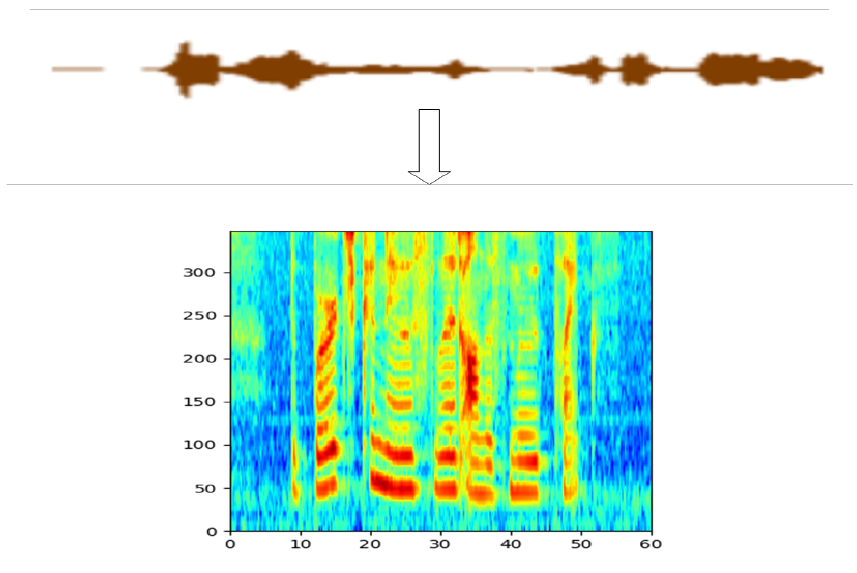
Figure 2. Example of extracting MFCC features from audio